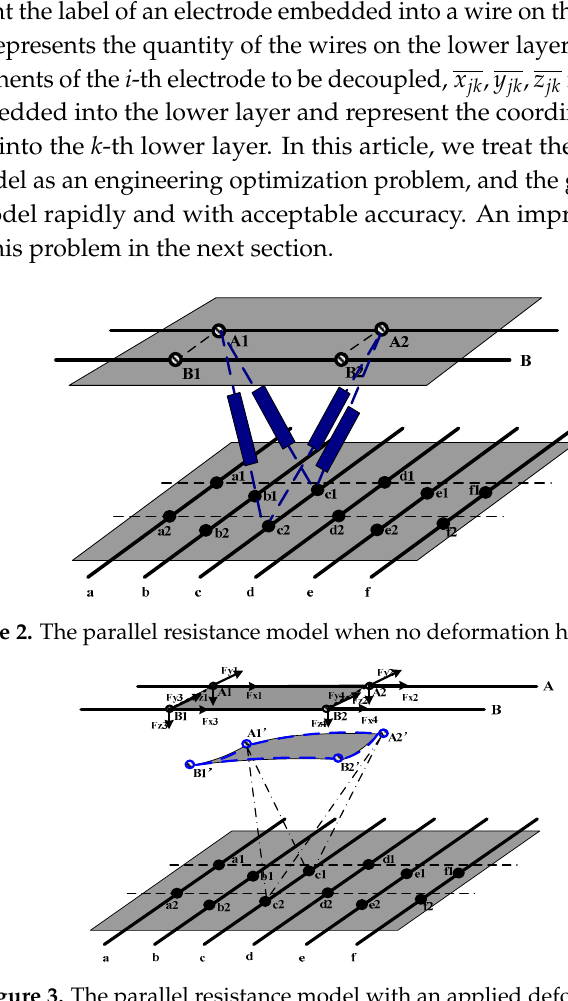
Figure 3. The parallel resistance model with an applied deformation.